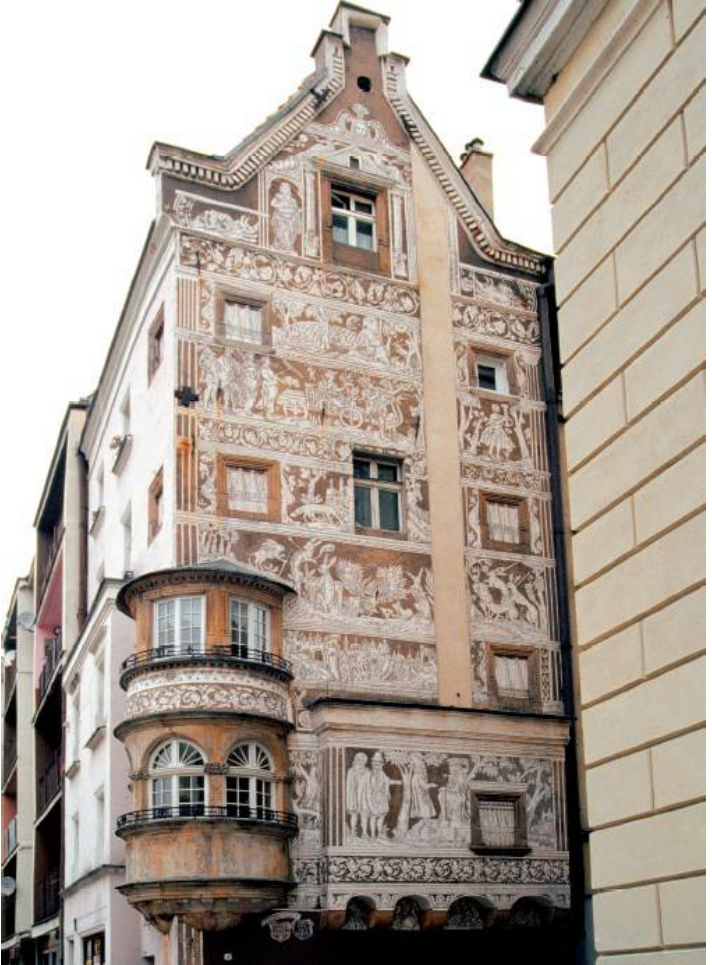
Figure 27. House “Under the Quail’s Basket” (Pod Przepiórczym Koszem) in Legnica. Sgraffito decoration after conservation in 1909, 1971 and 1993–1994. Author’s photo, 2003.